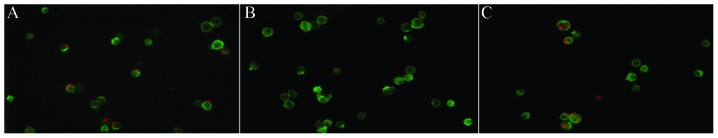
Apoptotic cell morphology under the fluorescence microscope. (A) Untreated serum group; (B) Quanzhenyiqitang-treated serum group; (C) aminophylline-treated serum group. Magnification, ×200.